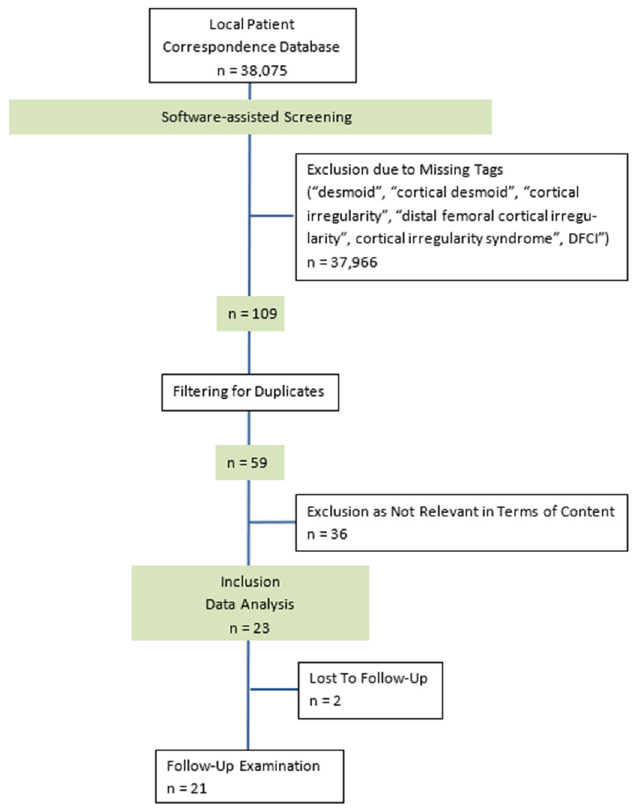
Figure 2. CONSORT diagram presenting the enrolment of the final study population according to [16]. Inclusion and data analysis of n = 23 patients; follow-up examination available for n = 21 patients ( n = 2 lost to follow-up).